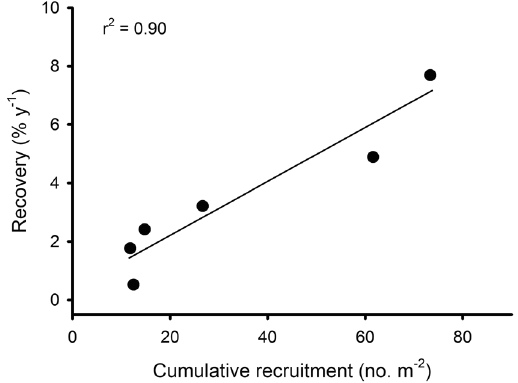
Figure 3. Relationship between the cumulative number of Pocillopora recruits per m 2 from 2011 to 2014 and the rate of return of coral cover at 6 sites around Moorea. Line shows fit from least squares linear regression. N = 48,203 recruits observed during the time period at the six